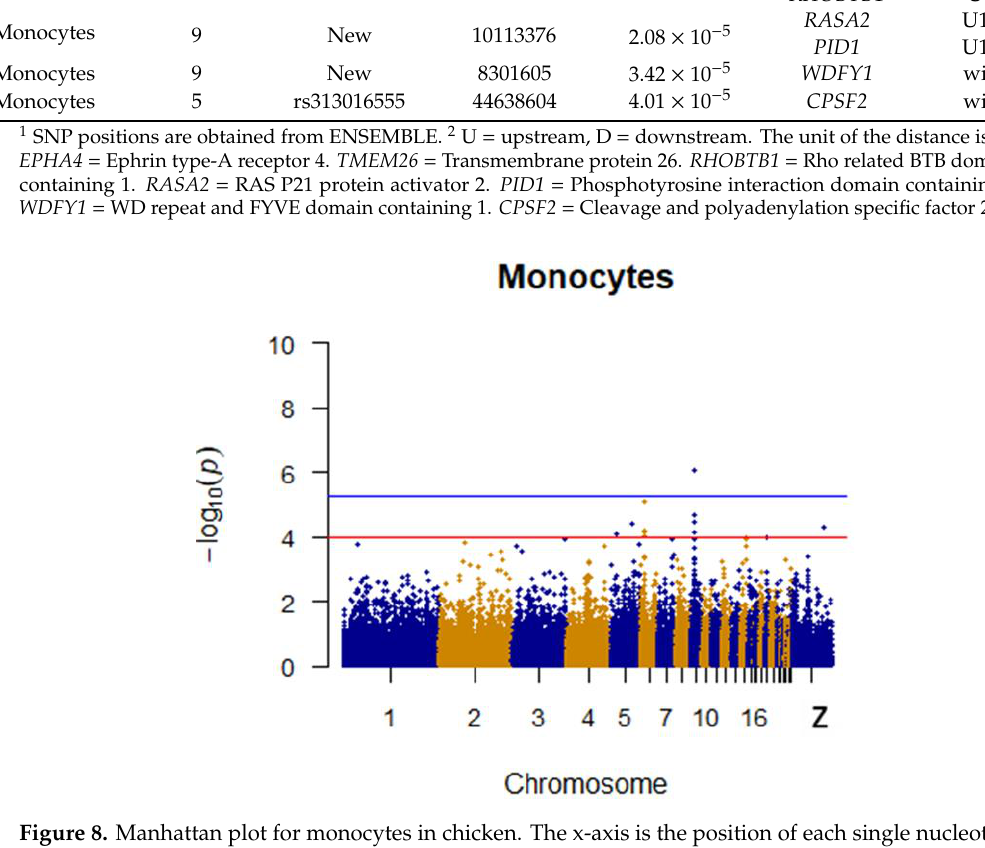
Figure 8. Manhattan plot for monocytes in chicken. The x-axis is the position of each single nucleotide polymorphism (SNP) on the chicken chromosomes 1–28 and linkage group and the y-axis is the − log10 p -value.